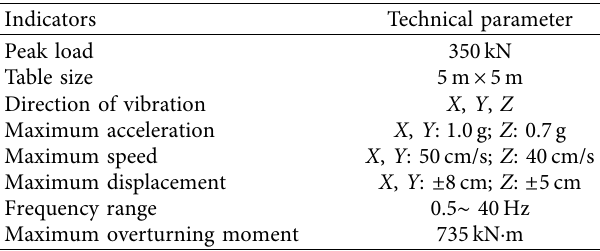
Table 1: Technical parameters of earthquake simulation shaking table.